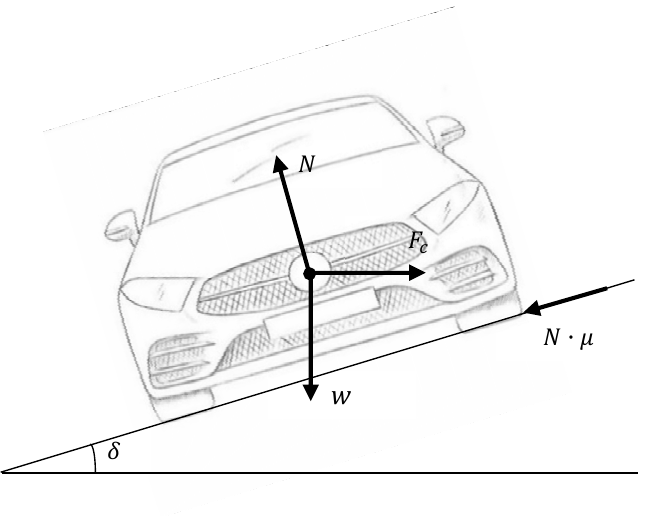
Figure 3. Forces applied on the vehicle.